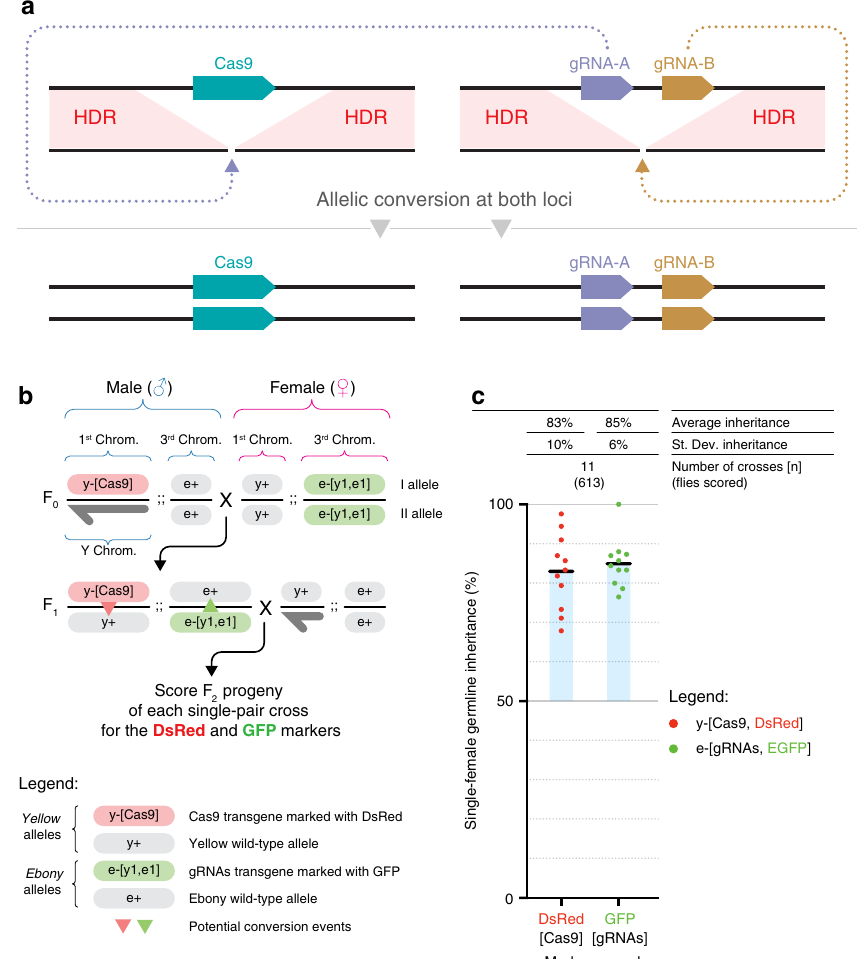
Fig. 1 The tGD system allows simultaneous super-Mendelian inheritance of two transgenes. a Schematic of the tGD genetic arrangement with two elements that can be kept separated as different transgenic lines. The Cas9 transgene is inserted in the genomic location targeted by the gRNA-A, while a separate cassette expressing a tandem-gRNA construct (gRNA-A, gRNA-B) is inserted at the location targeted by gRNA-B. Upon genetic cross, each of the gRNA-A and gRNA-B combines with Cas9 to generate a double-strand DNA break at each locus on the wild-type allele (dotted purple and brown arrows, respectively). Each break is then repaired by the homology-directed repair (HDR) pathway using the intact chromosome carrying the transgene as a template. b Outline of the genetic cross used to demonstrate tGD in fruit fl ies, indicating transgenes and wild-type allele location on different chromosomes. Sex of the individuals is indicated with symbols “ ♂ ” for males and “ ♀ ” for females. F 0 males carrying a DsRed-marked Cas9 transgene inserted into the yellow locus were crossed to females carrying a GFP-marked cassette containing two gRNAs ( y 1 – e 1) inserted into the ebony coding sequence. Transheterozygous F 1 females (carrying both Cas9 and gRNAs) were crossed to wild-type males to assess germline transmission rates of the fl uorophores marking the transgenes in the F 2 progeny. The conversion events are indicated by the red and green triangles in the F 1 females. c Single F 1 female germline inheritance output is measured as GFP and DsRed marker presence in the F 2 progeny. The black bar represents the inheritance average. The blue shading represents the deviation from the expected 50% “ Mendelian ” inheritance. Inheritance average, standard deviation, number of samples ( n ), and total number of fl ies scored in each experiment are represented over the graph in line with the respective data. Raw phenotypical scoring is provided as “ Supplementary Data 1 ”